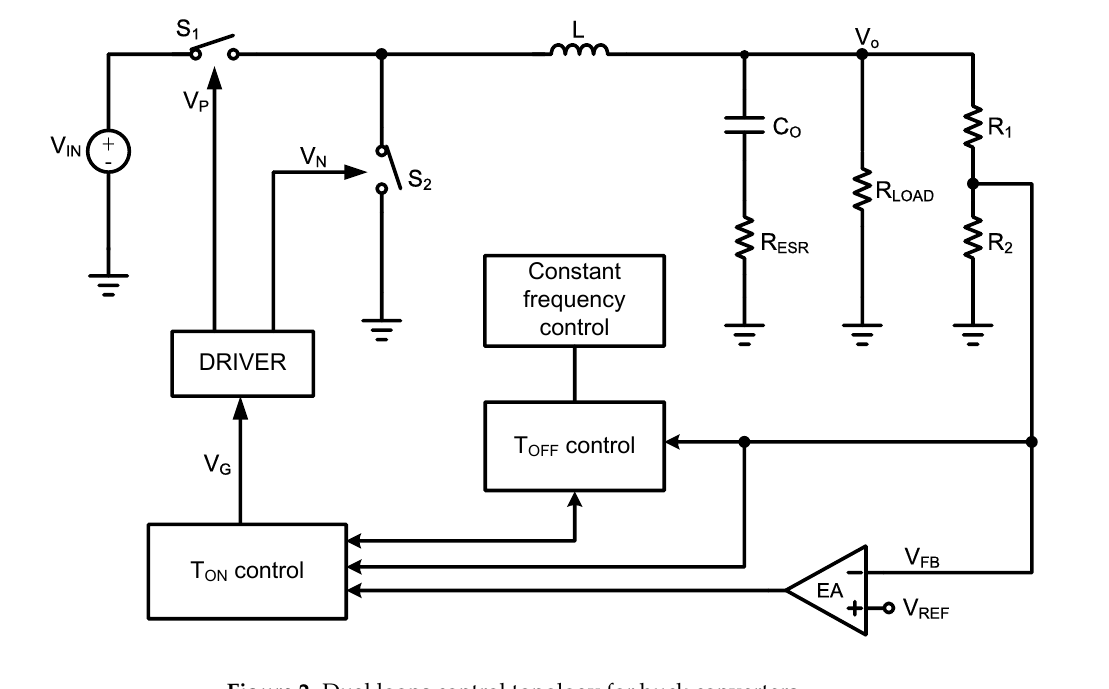
Figure 1. Buck topology with a virtual inductor current sensor.